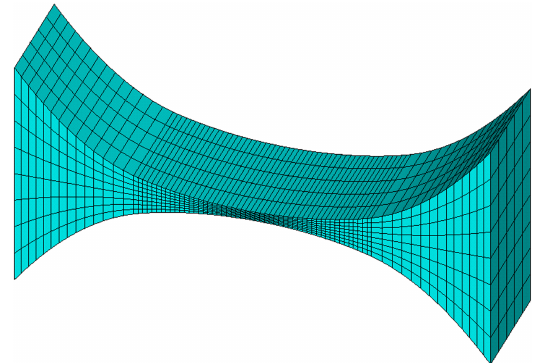
Figure 7. The finite element model in ANSYS.